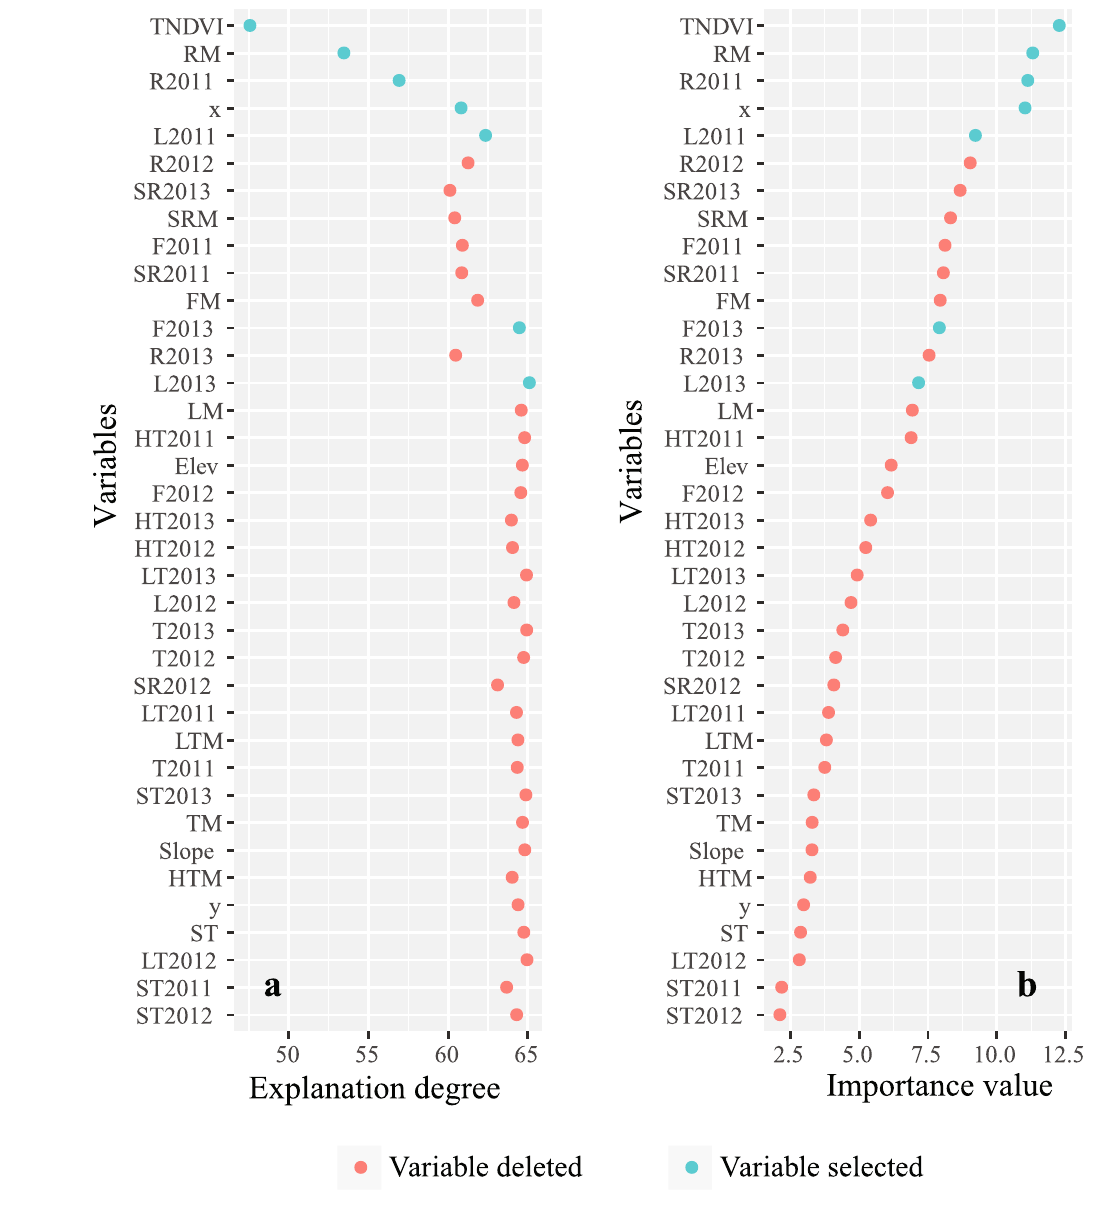
Figure 6. Variable selection for the RF model. The meaning of factors referred to Table